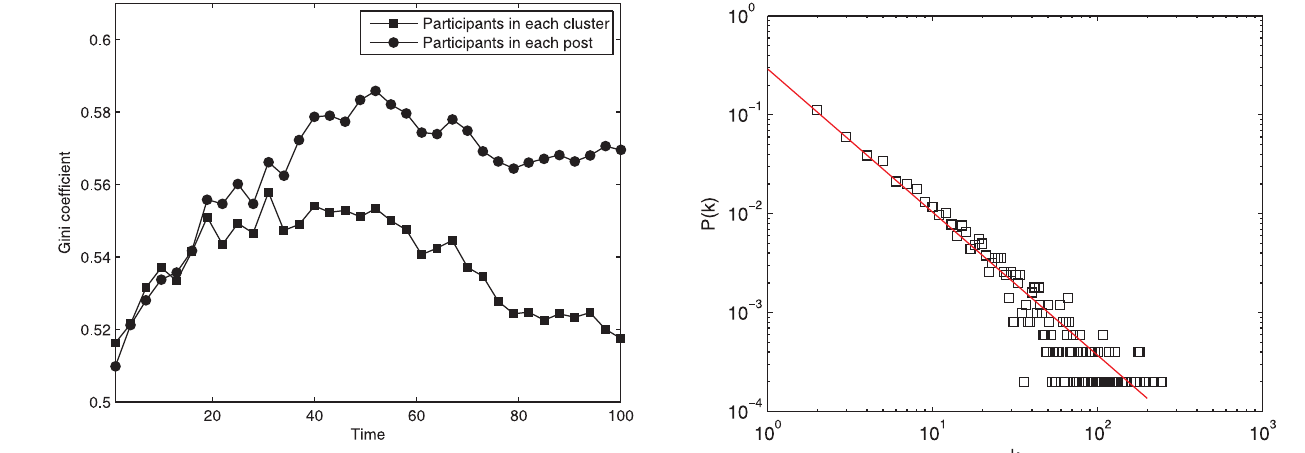
Figure 9. Degree distribution of our user network, N ~ 5000 , l ~ 0 : 001 , d ~ 0 : 5 . User nodes have a power-law degree distribution with the power exponent { 1 : 447 + 0 : 009 .